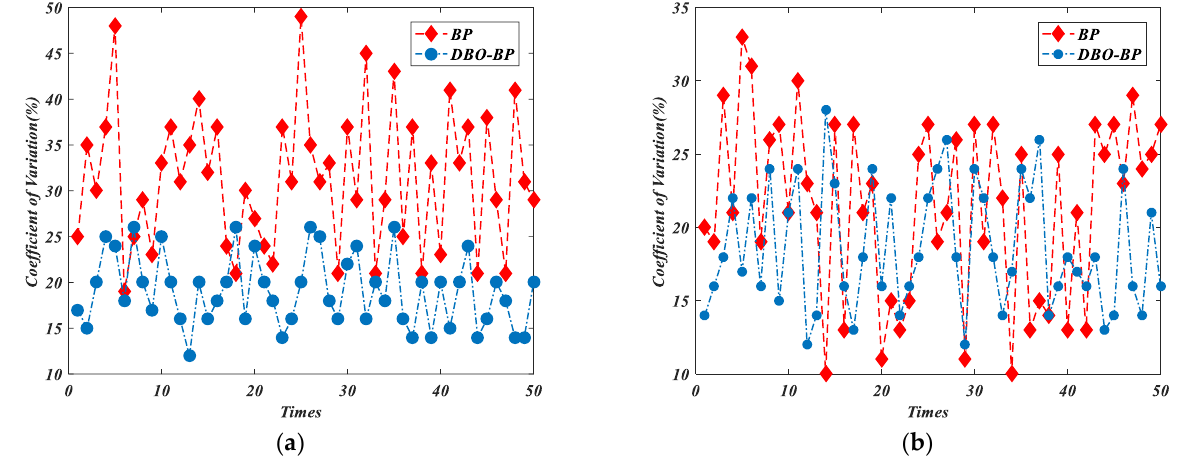
Figure 8. Comparison of model performance before and after optimization. ( a ) PE debonding; ( b ) IC